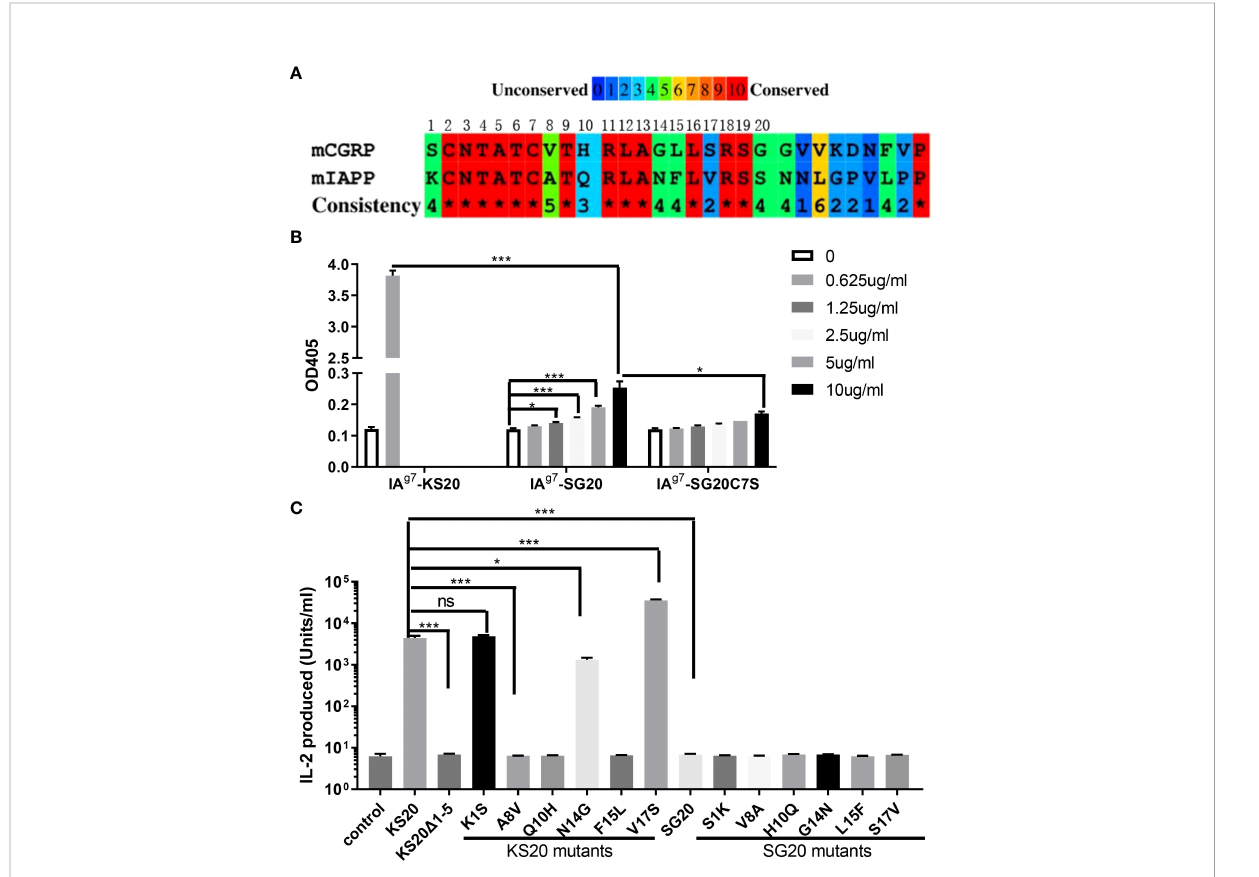
FIGURE 3 The essential amino acids of KS20 peptide for the activation of T cell BDC5.2.9 compared with the SG20 peptide. (A) Amino acid sequence alignment of mouse CGRP and IAPP segments studied here. (B) mAb LD96.24 bound weakly to IA g7 -SG20 molecules. The binding between mAb LD96.24 and IAg7-SG20 molecules was measured by ELISA. Results are the means ± SEM of triplicate wells. (C) Viruses encoding WT KS20, WT SG20, KS20 mutants, and SG20 mutants were used to infect mouse ICAM + B7 + SF9 insect cells. KS20 △ 1-5 and non-infected wells were used as controls. 3 days later, these insect cells were used as APCs to stimulate BDC5.2.9 T cells. Results are the means ± SEM of triplicate wells. * P < 0.05, ** P < 0.01, *** P <